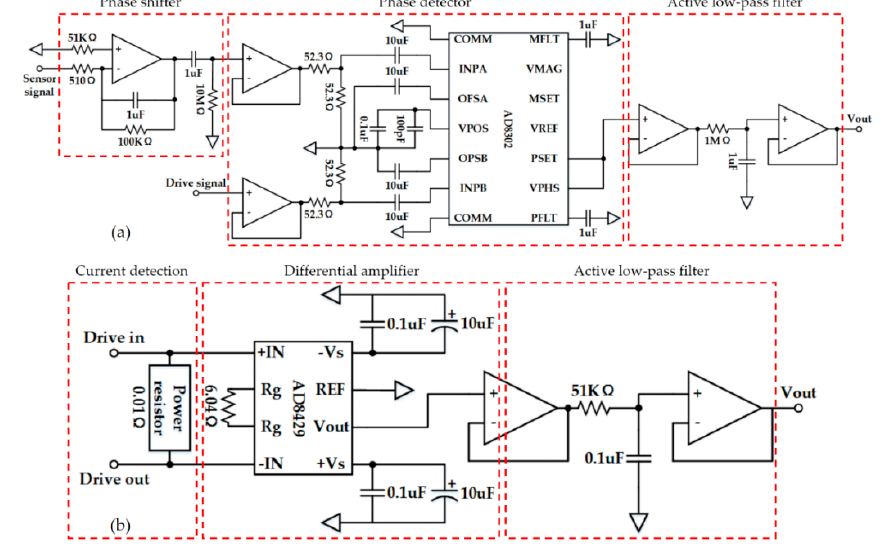
Figure 5. ( a ) Circuit of the phase detector; ( b ) circuit for current detection.